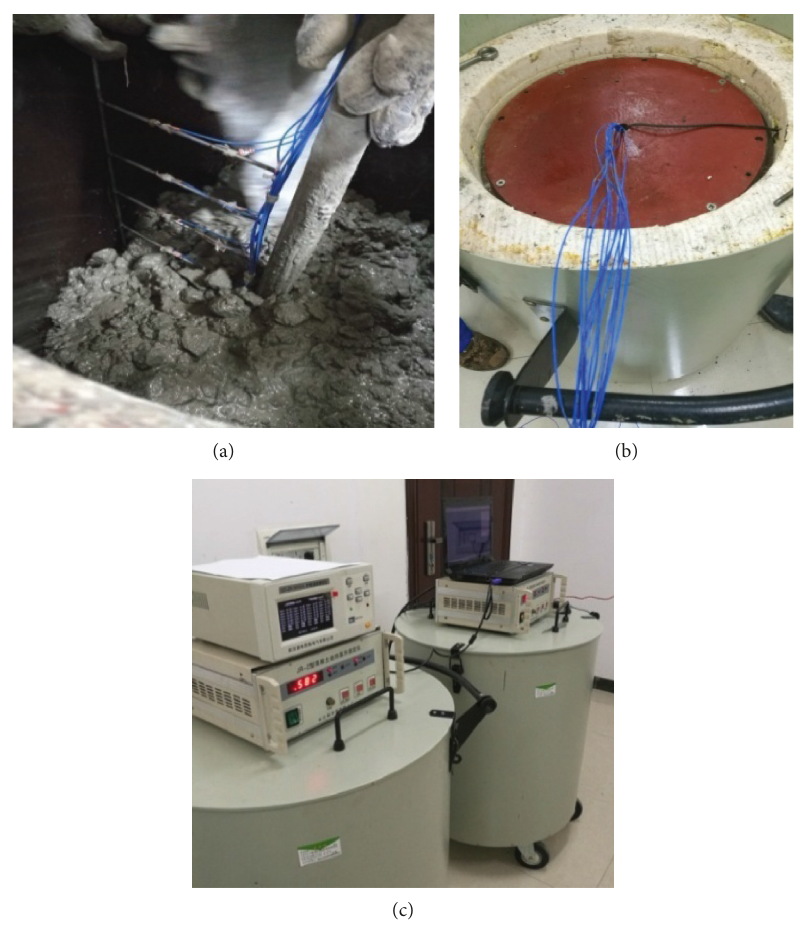
Figure 2: Experimental specimen and